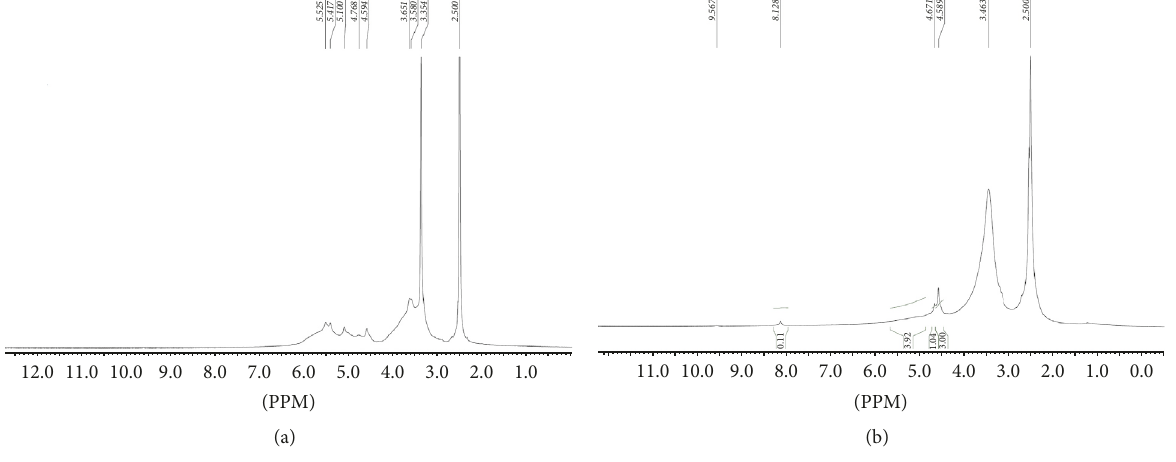
Figure 3: NMR spectra of native (a) and modified (b) potato